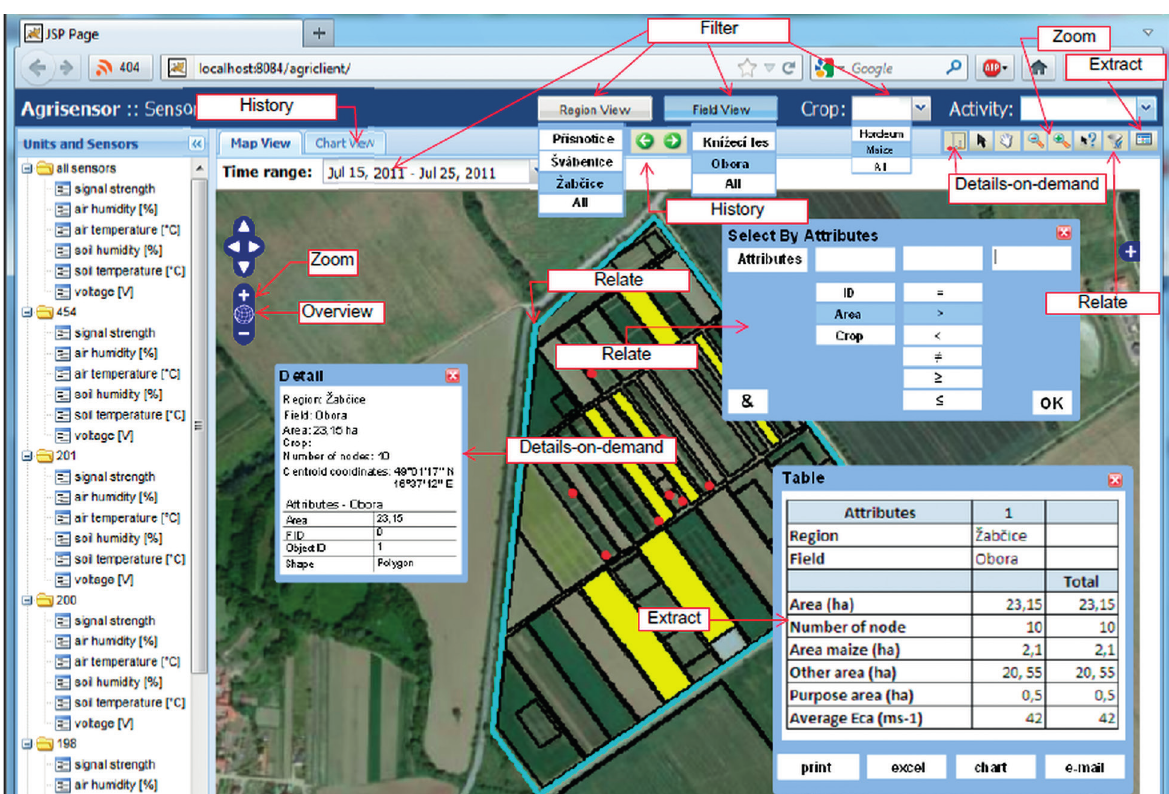
Fig. 7. Client window (the same context as in Fig. 3) with description of visual seeking tools. Adapted from: Tynklova